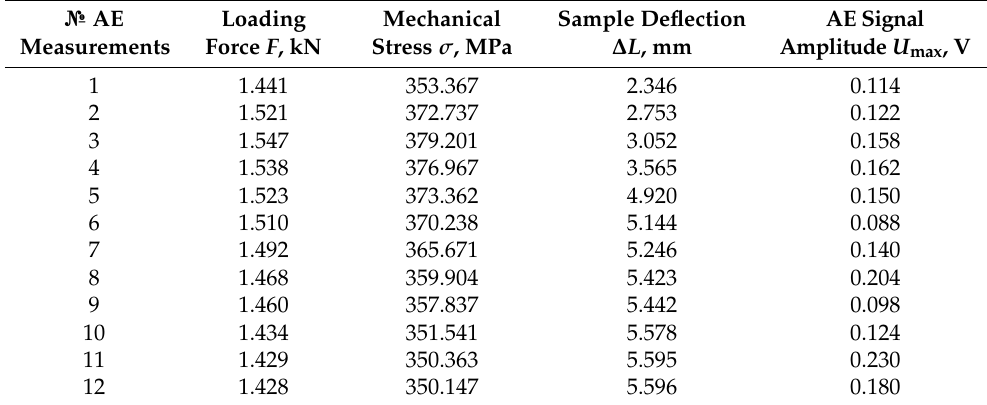
Figure 7. The sequence of received AE signals in the order of their occurrence and fixation during sample loading. Table 1. Experimental values of the main characteristics during four-point bending of samples at the moments of successive fixation of AE signals.